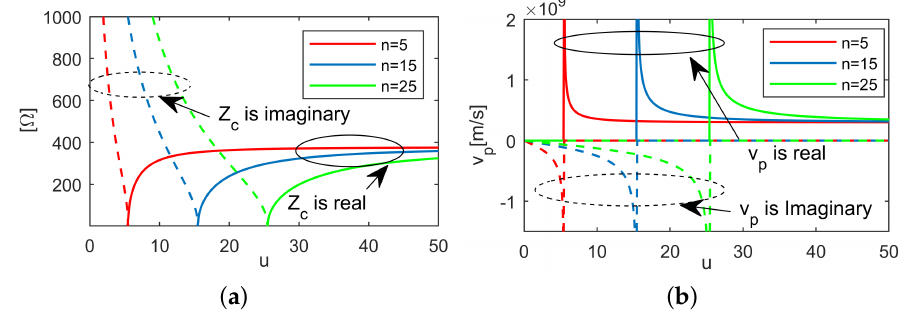
Figure 4. Parameters for TM nm mode. n = 5,15,25. ( a ) Characteristic impedance. ( b ) Phase